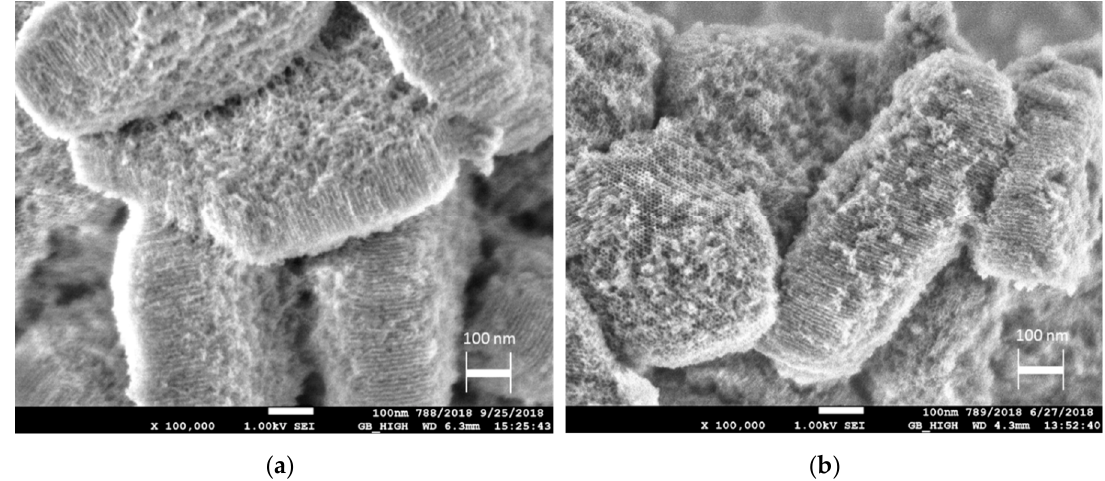
Figure 4. SEM images of 1%V/Zr ‐ SBA ‐ 15 I ( a ) and 1%V/Zr ‐ SBA ‐ 15 II ( b ) catalysts (all images × 100,000).